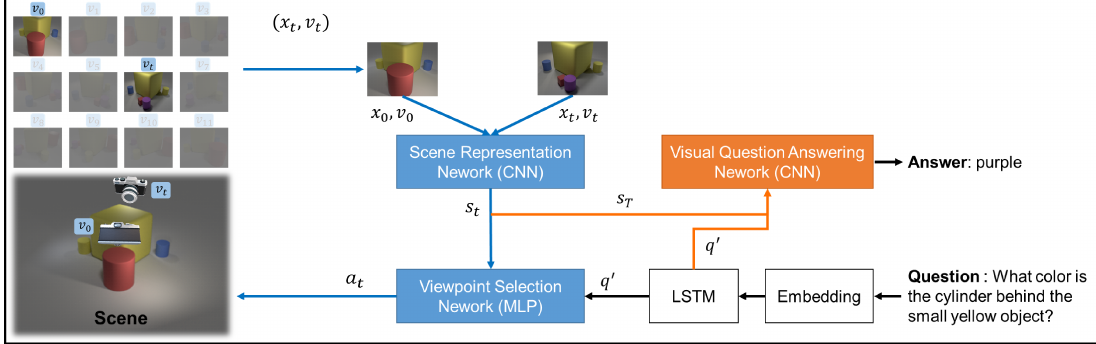
Figure 2. Overall framework. The viewpoint selection network (multi-layer perceptron (MLP)-structured) chooses the observation viewpoint (or ends the observation) iteratively based on the scene s t and question q (cid:48) (blue arrow